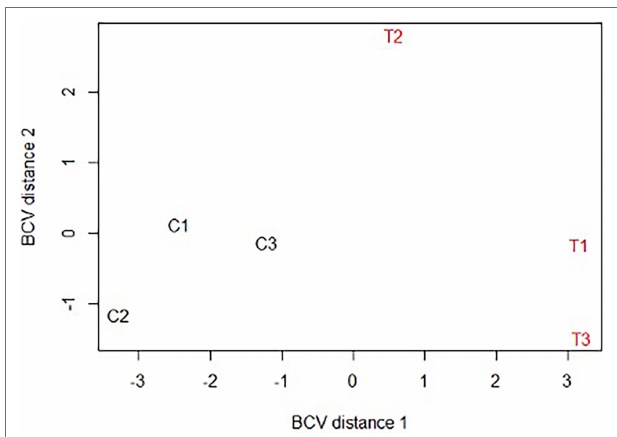
FIGURE 2 | Multidimensional scaling plot (MDS) of Rhipicephalus microplus CERM-depleted and control metanymphs. C1, C2, C3: CERM metanymphs; T1, T2, T3: CERM-free metanymphs. BCV, Biological coefficient of